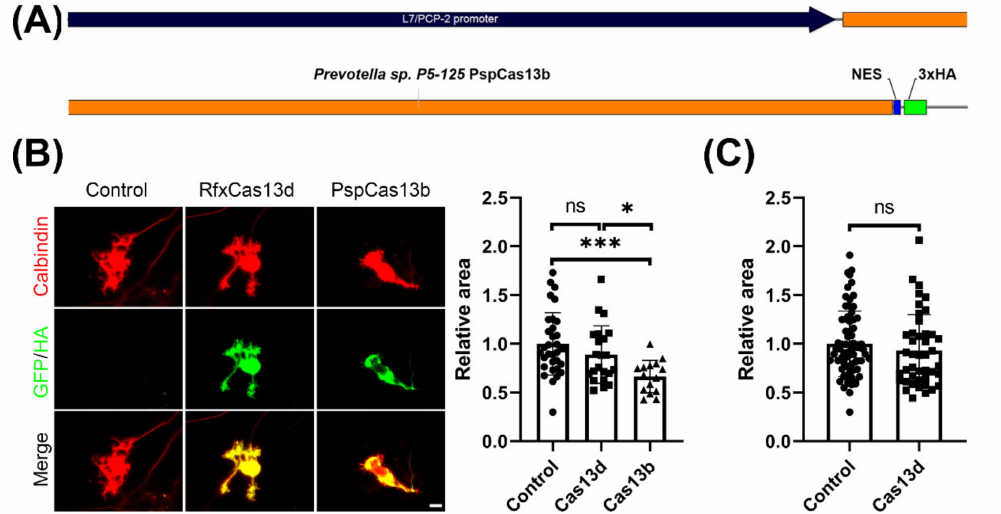
Figure 2. Purkinje-specific PspCas13b expression inhibits Purkinje cell dendritic growth. ( A ) A schematic view of the Purkinje cell specific PspCas13b expression vector. ( B ) The mean values of the Purkinje cell dendritic area were measured in three independent culture experiments. Representative images of transfected Purkinje cells are shown left. Scale bar is 20 µ m. Control cells were non-transfected Purkinje cells from the same culture wells. Control: 1.00 ± 0.320, n = 33 cells; RfxCas13d 0.89 ± 0.295, n = 22 cells; PspCas13b 0.66 ± 0.166, n = 15 cells; Control vs. RfxCas13d, not statistically significant (ns); Control vs. PspCas13b, p = 0.0002 (***); RfxCas13d vs. PspCas13b, p = 0.0241 (*) in one-way ANOVA with Kruskal–Wallis test; Data are expressed as mean ± SD. ( C ) In order to exclude a negative effect of RfxCas13d, we increased the number of analyzed cells. The results confirm that RfxCas13d had no or only a minor negative effect on the Purkinje cell dendritic area. Control 1.000 ± 0.3365, n = 71 cells, RfxCas13d 0.929 ± 0.3707, n = 43 cells, difference was not statistically significant in two-tailed Mann–Whitney